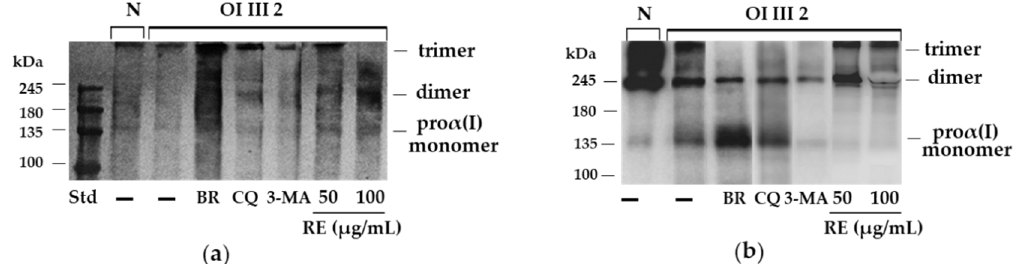
Figure 7. Polyubiquitynation ( a ) and SDS-PAGE of silver-stained ( b ) procollagen type I monomers, dimers and trimers, performed under non-reducing conditions in normal (N) and OI III 2 cells treated with 50 and 100 µ g/mL rosemary extract (RE), 50 nM bortezomib (BR), 50 µ M chloroquine (CQ), and 5 mM 3-methyladenine